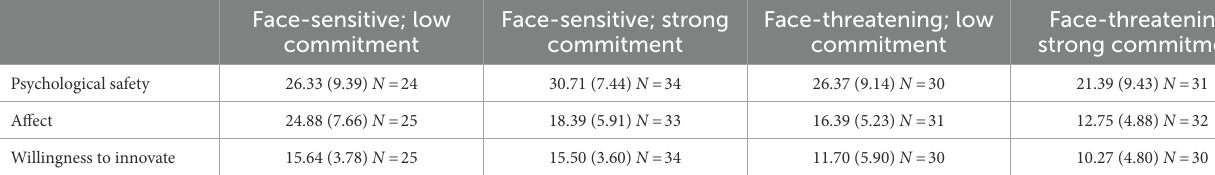
Face-threatening; low commitment